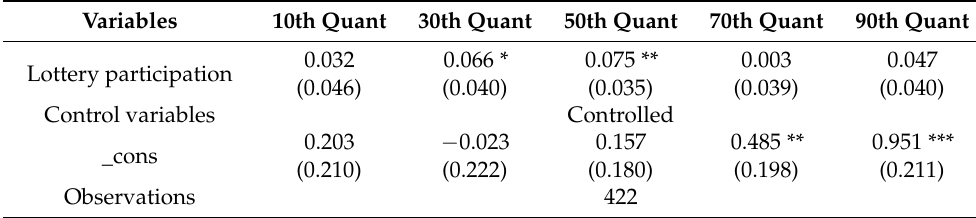
Table 7. Quantile regression model estimation results.